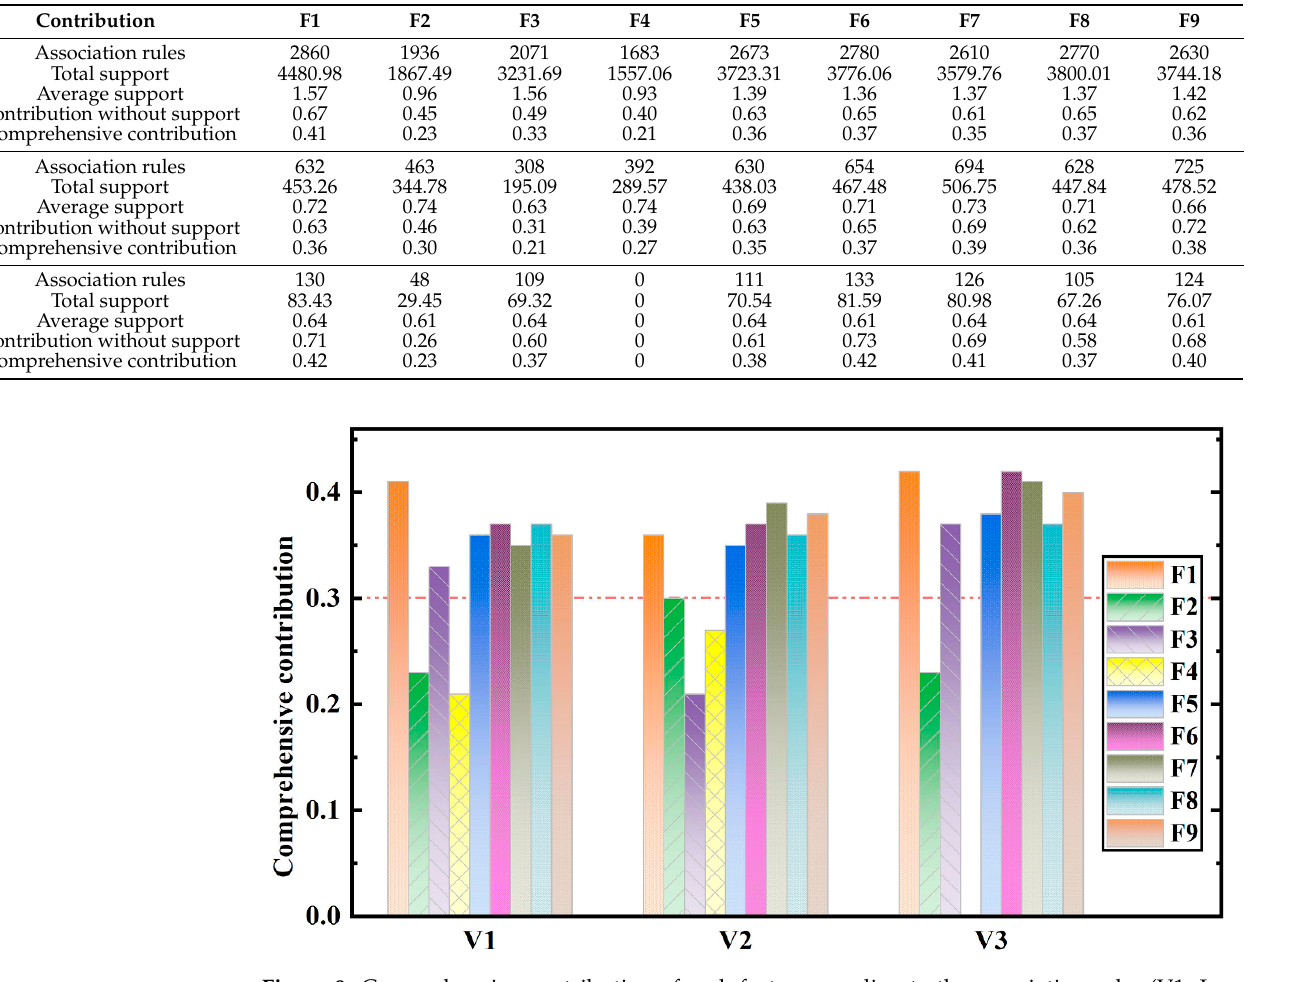
Table 5. Statistical results of the data mining and association rules.